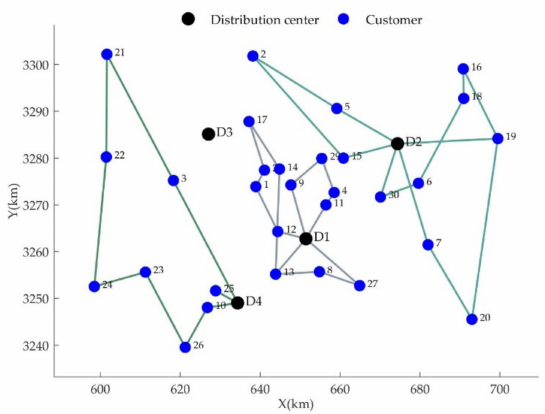
Figure 9. Location-routing scheme solved by ACO-TS. Table 10. Comparison of solution efficiency between ACO-TS and ACO.